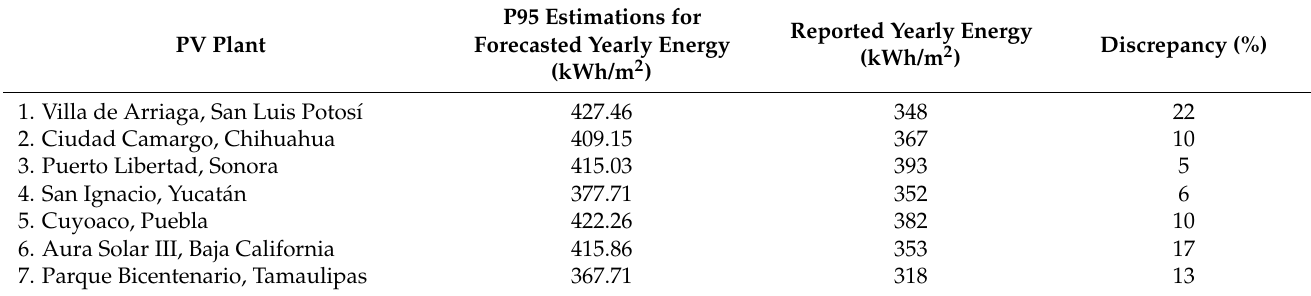
Table 4. Validation of the results for P 95 forecasting by comparing PV forecasted energy with the real generation of some PV power plants throughout Mexico.